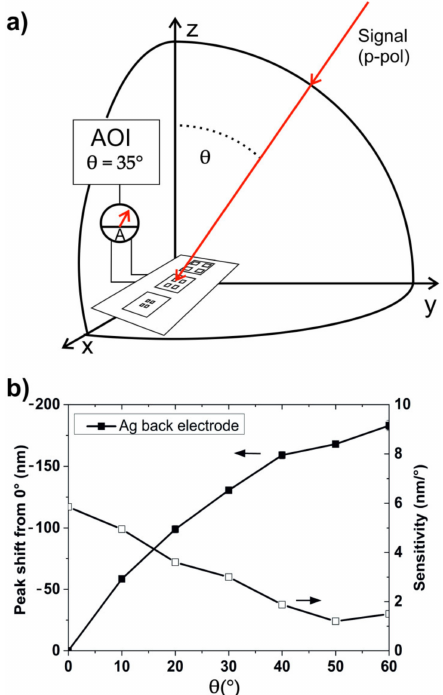
Figure 6. ( a ) Schematic illustration of the detector concept used for the detection of the AOI of incoming light. ( b ) Sensitivity and spectral shift of the resonance peak depending on the angle of